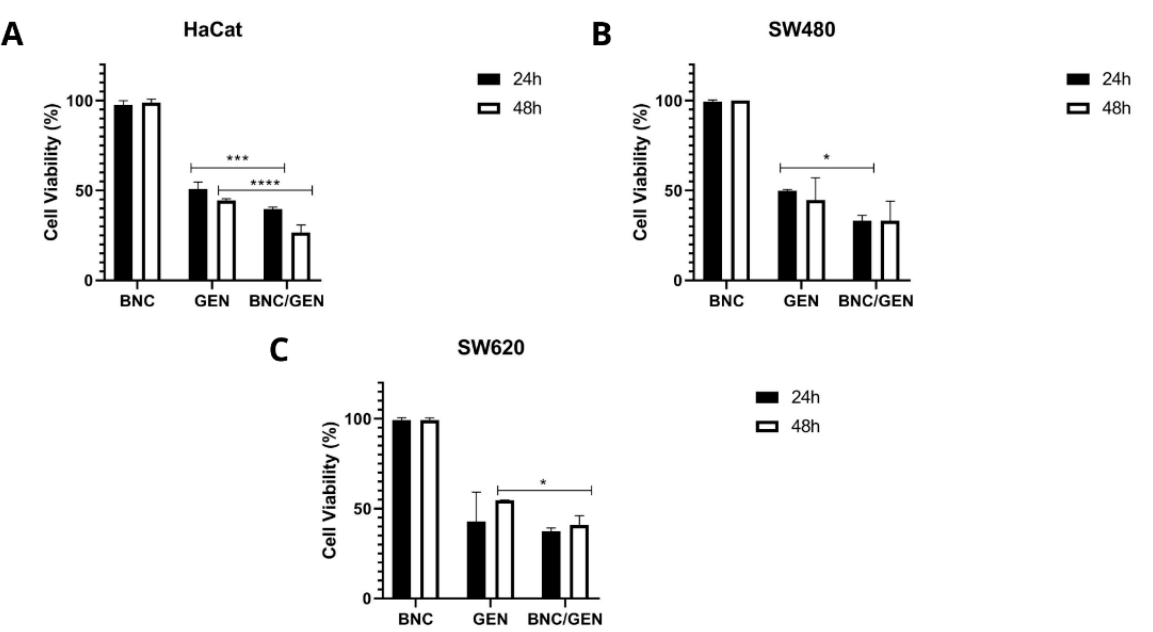
Figure 4. Cell viability of empty BNC capsules and BNC/GEN capsules, taking into account the IC 50 value of free genistein, after 24 and 48 h ( A ) non-malignant HaCaT cell line, ( B ) SW480 colorectal adenocarcinoma cell line, and ( C ) SW620 colorectal adenocarcinoma cell line. p -value < 0.05 *; p < 0.001 ***; and p < 0.0001 ****.